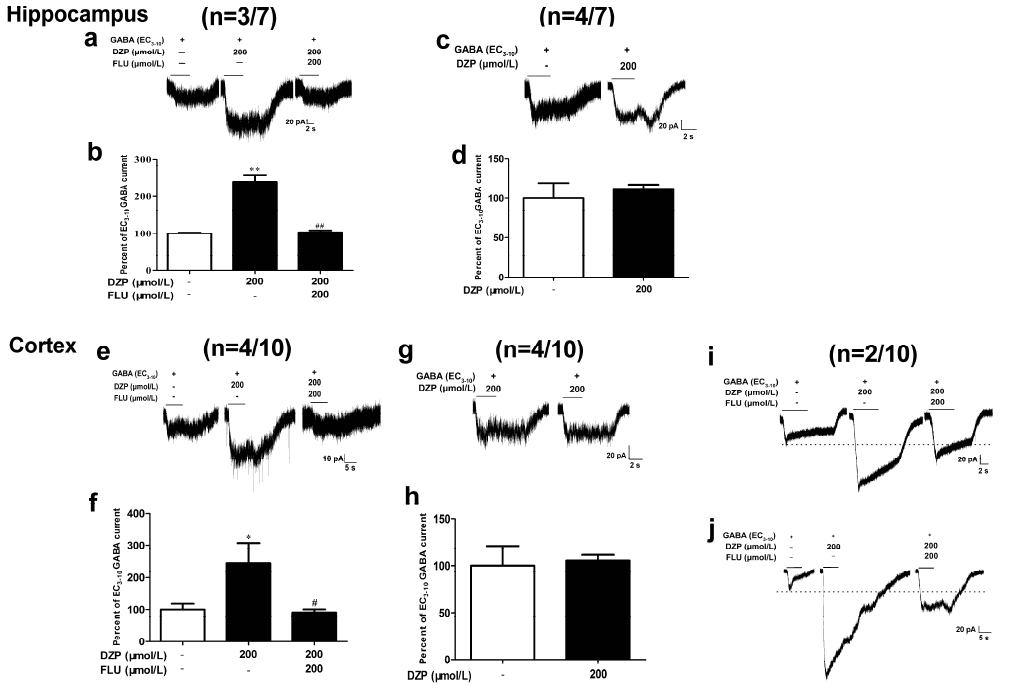
Figure 6. Modulatory e ff ects of diazepam on hippocampal and cortical neurons. Diazepam (200 µ mol / L) was co-applied with GABA (EC 3-10 , 1 µ mol / L for hippocampal and 3 µ mol / L for cortical neurons) to acutely dissociated neurons. Diazepam potentiate GABA currents on some hippocampal (3 / 7, a , b ) and cortical (4 / 10, e , f ) neurons and flumazenil (200 µ mol / L) antagonized the e ff ects. (4 / 7) hippocampal ( c , d ) and (4 / 10) cortical ( g , h ) neurons were insensitive to diazepam. ( i , j ) Current traces from two cortical neurons (2 / 10) showed the partial antagonism of flumazenil on diazepam. One-way ANOVA with Dunnett’s post hoc tests; * p < 0.05, vs. control group, # p < 0.05, vs. DZP group; n =